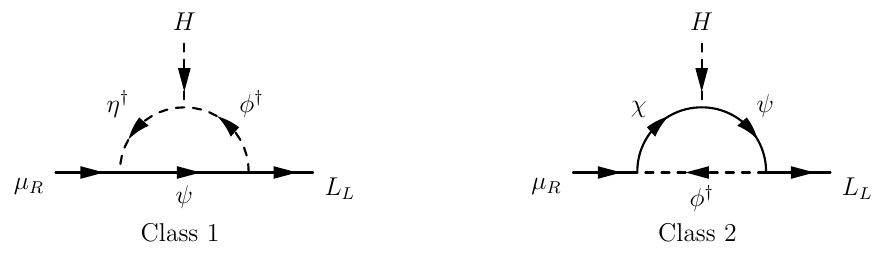
Figure 1 . One-loop diagrams that generate effective muon Yukawa couplings after integrating out the heavy, exotic